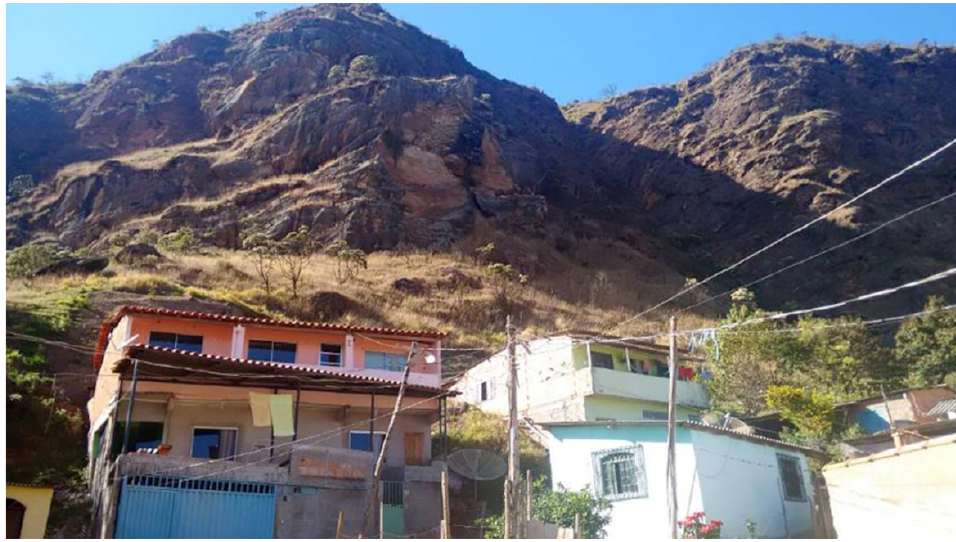
Figure 3. Slope ‐ 1 overview. Figure 3. Slope-1